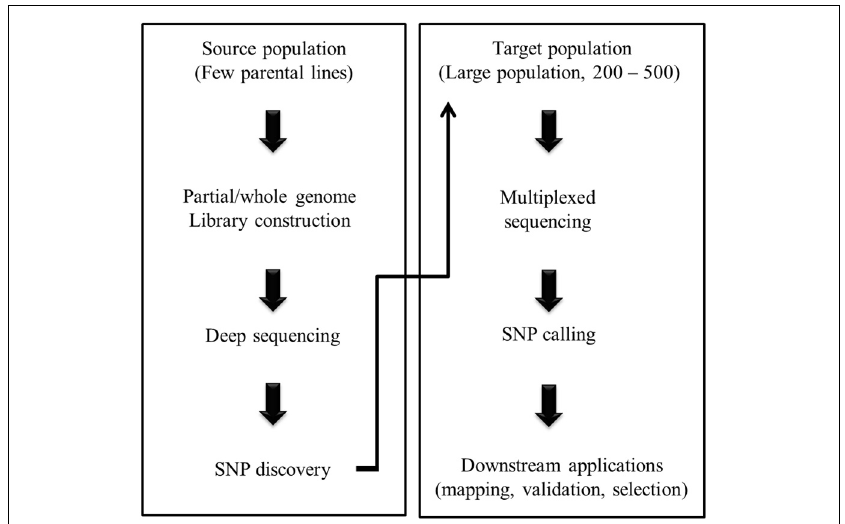
FIGURE 1 | A general outline of NGS assisted plant breeding.